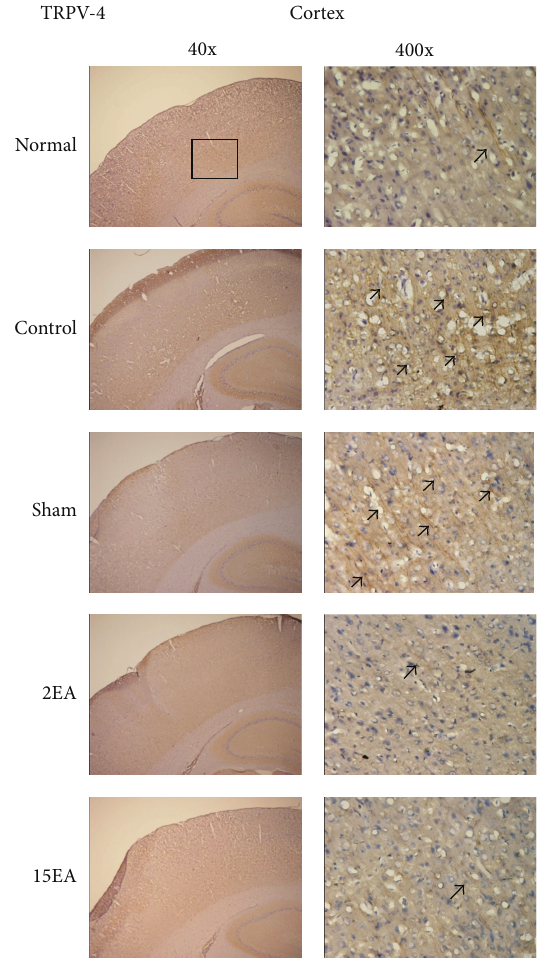
Figure 2: Effect of EA on cortical TRPV4 immunostaining posi- tive cells in SD rats with CCI-induced neuropathic pain. TRPV4 immunostainingpositivecells(arrow)ofthecerebralcortex(cortex) increased in the control group without treatment (control) than those in the normal group (normal). These increases were reduced for the 2EA (2EA) and 15EA (15EA) treatment, but not for the Sham EA treatment (sham). normal = normal group; control = control group; sham = sham group; 2EA = 2EA group; 15EA = 15 EA group.